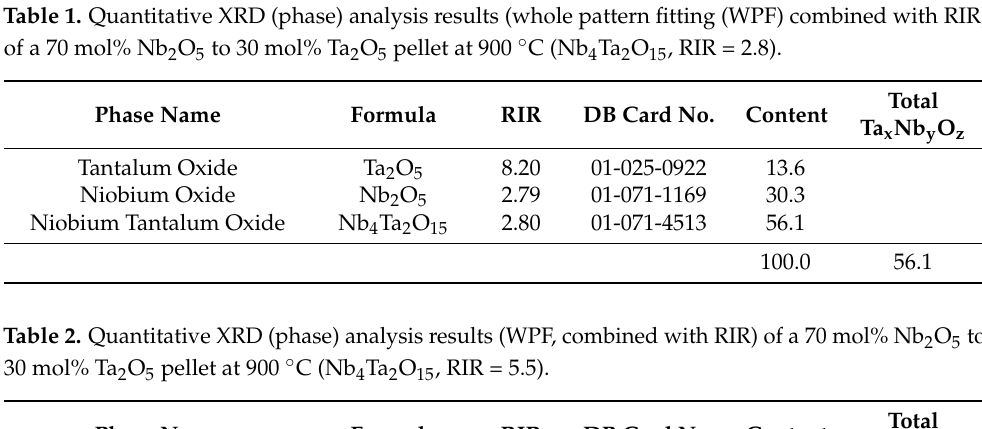
Table 1. Quantitative XRD (phase) analysis results (whole pattern fitting (WPF) combined with RIR)